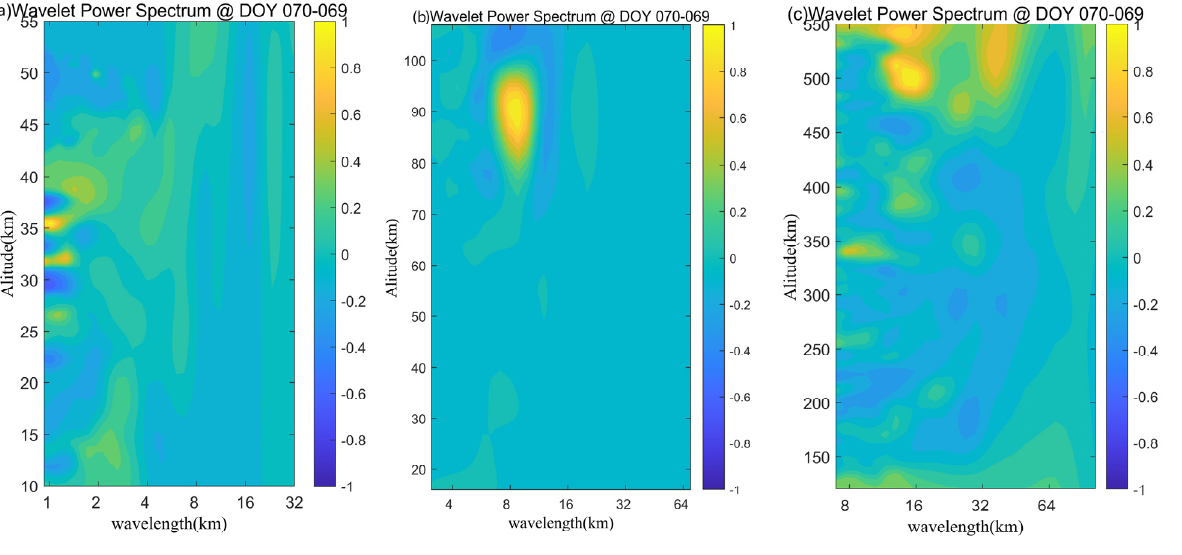
Figure 6. The wavelet power spectrum differences between DOY 69 and 70 of 2011 of ( a ) tempera- ture profiles detected by the F3/C atmPrf datasets, ( b ) temperature profiles detected by the SABER datasets, and ( c ) electron density profiles detected by the F3/C ionPrf datasets.